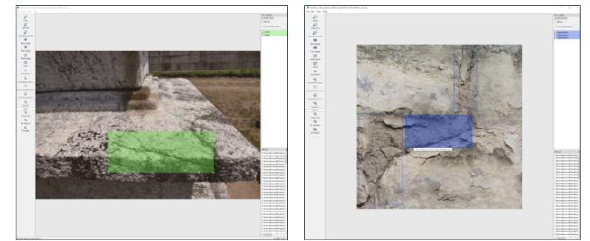
Figure 7. Image annotation using LabelImg.